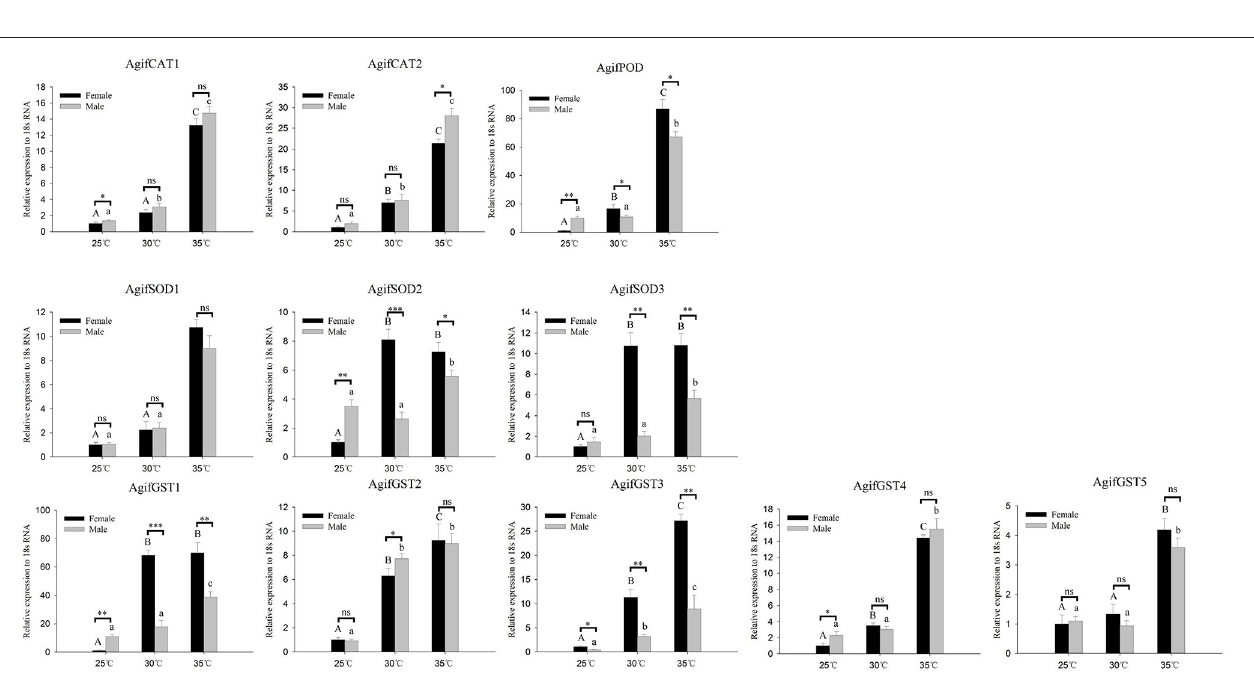
FIGURE 4 | Relative expression of A. gifuensis antioxidant enzyme genes under the short-term thermal treatment. Different letters over the bars designate a significant difference at P < 0.05. And “*” means P < 0.05, “**” means P < 0.01, “***” means P < 0.001.